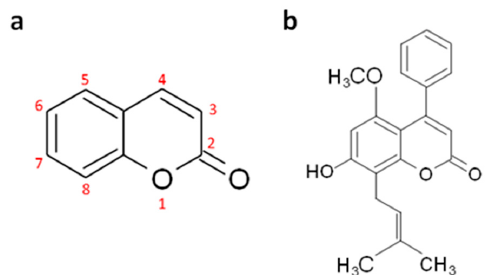
Figure 5. ( a ) Classical 1,2-benzopyrones chemical backbone and atom numbering of coumarins. ( b )